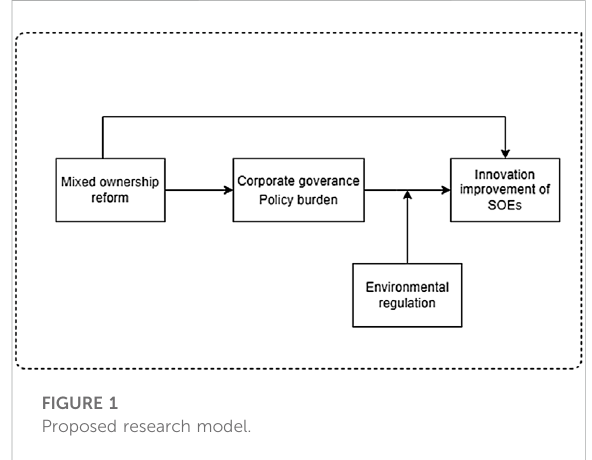
FIGURE 1 Proposed research